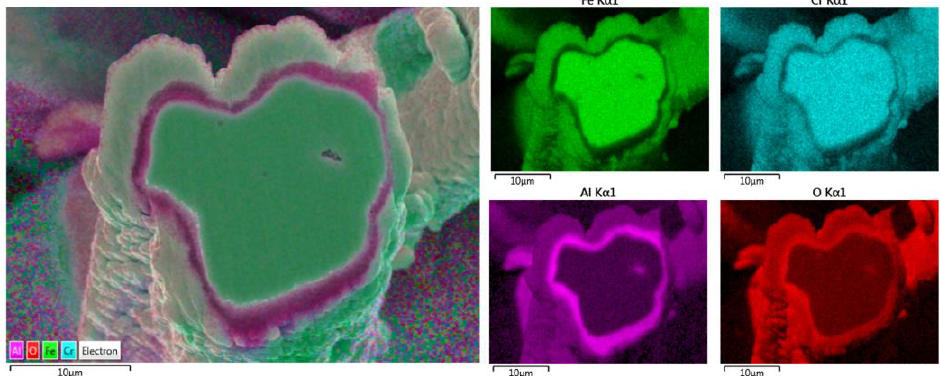
Figure 17. Elemental EDS mapping of Fe, Cr, Al, and O of a 17 μ m FeCrAl fiber after 18 MSHT cycles.